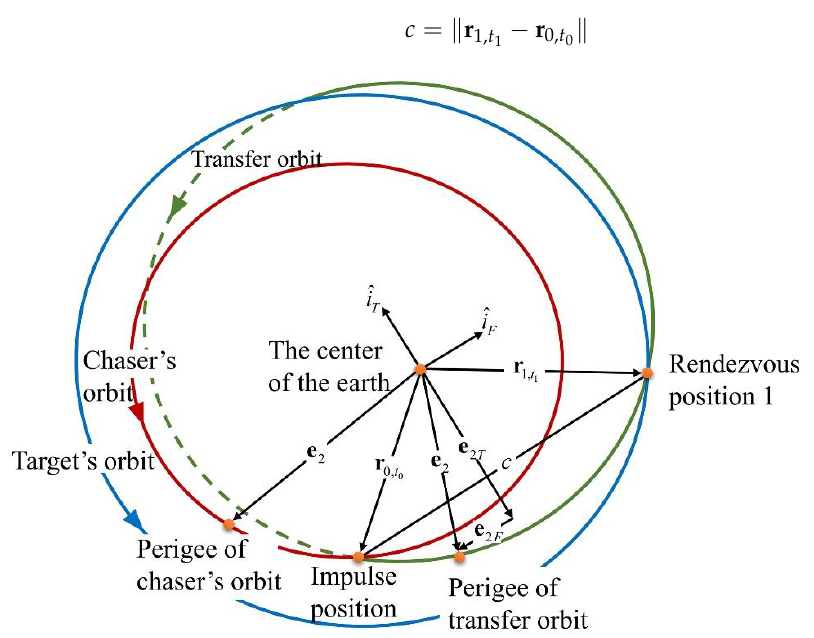
Figure 3. Geometric interpretation of coplanar Lambert problem.